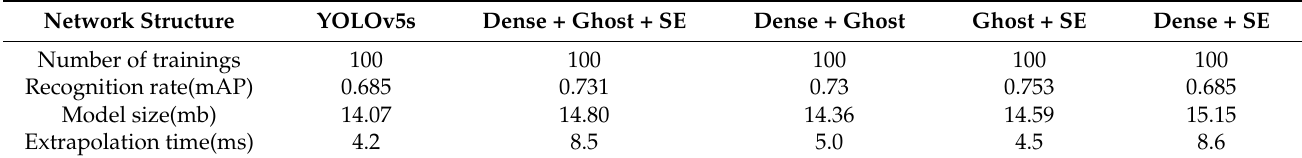
Table 6. Comparison table of results for the synthesis improved module.